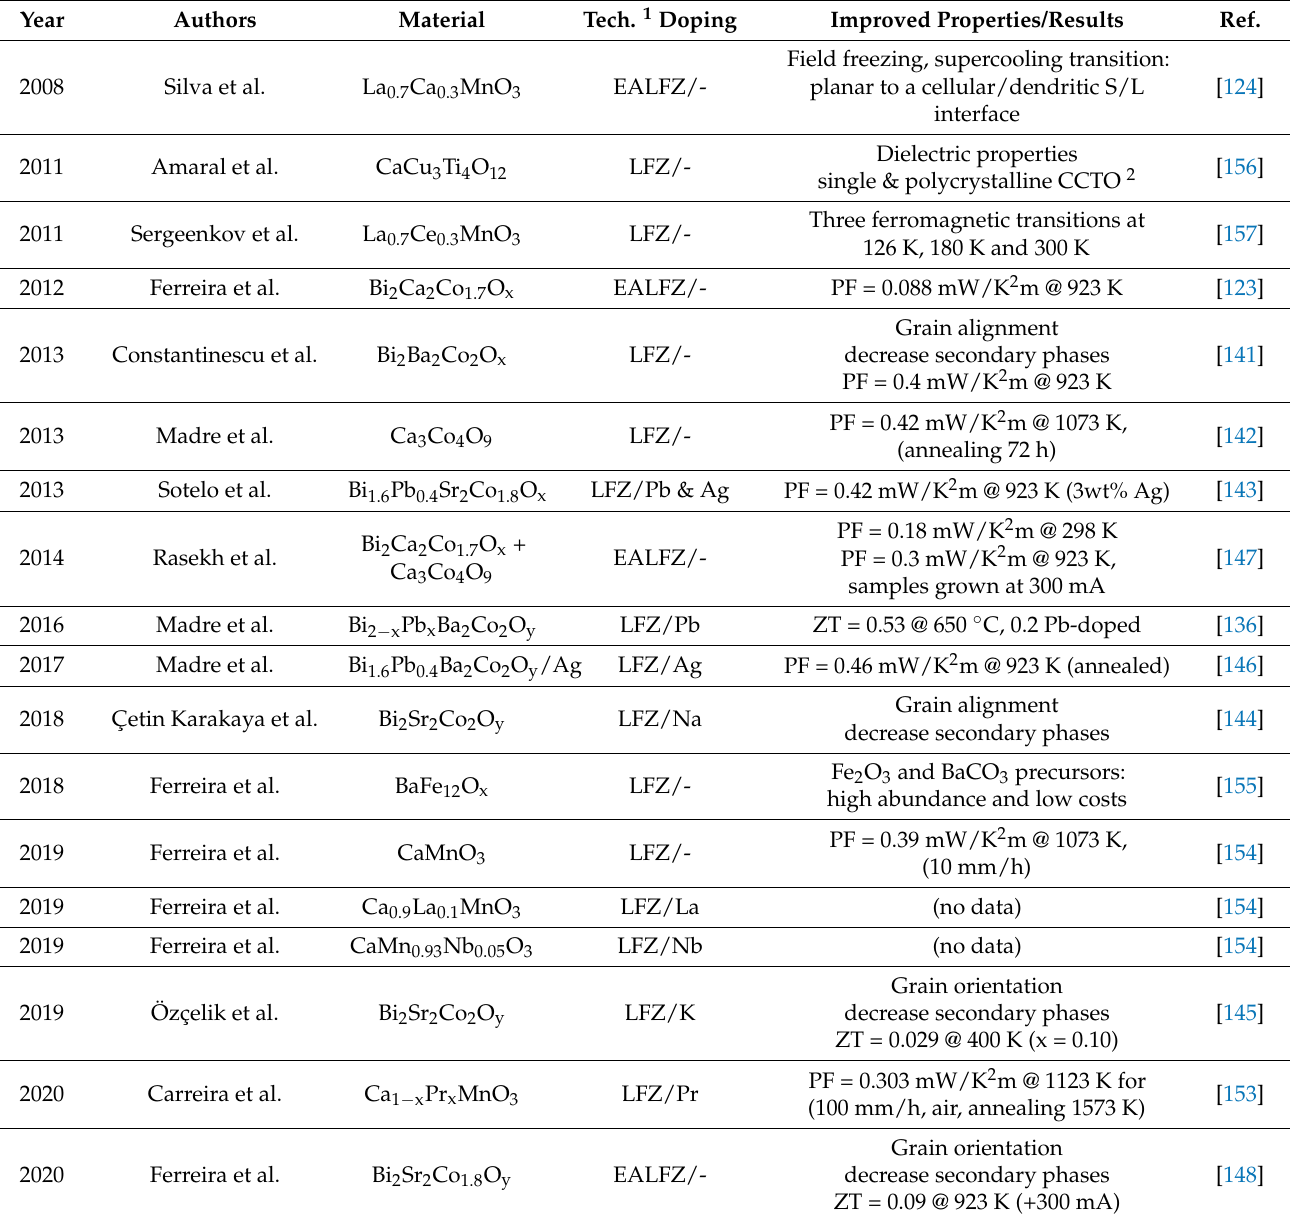
Table 5. Materials for electrical applications since 1999